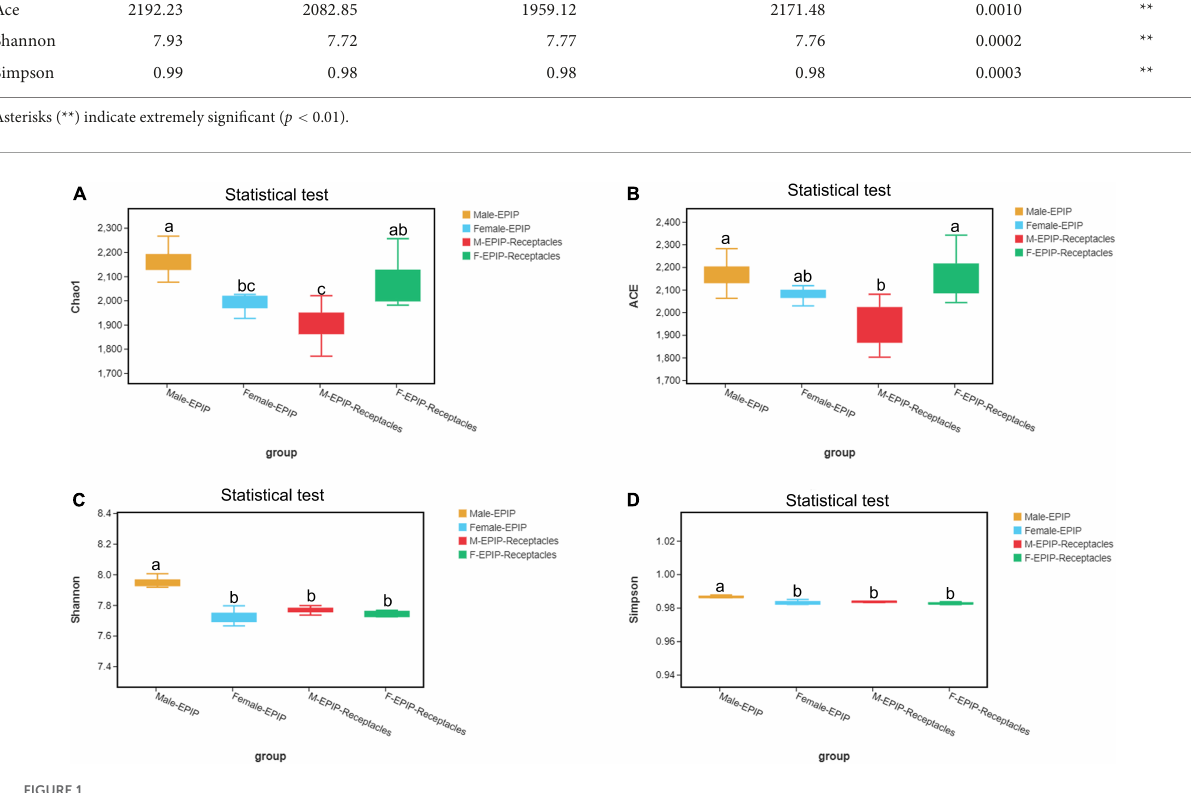
FIGURE1 Alpha diversity of epiphytic bacterial communities on male and female S. thunbergii and their receptacles were assessed using the Chao1 (A) , ACE (B) , Shannon (C) , and Simpson (D) index. Different letters denote significant differences (Tukey HSD, p <